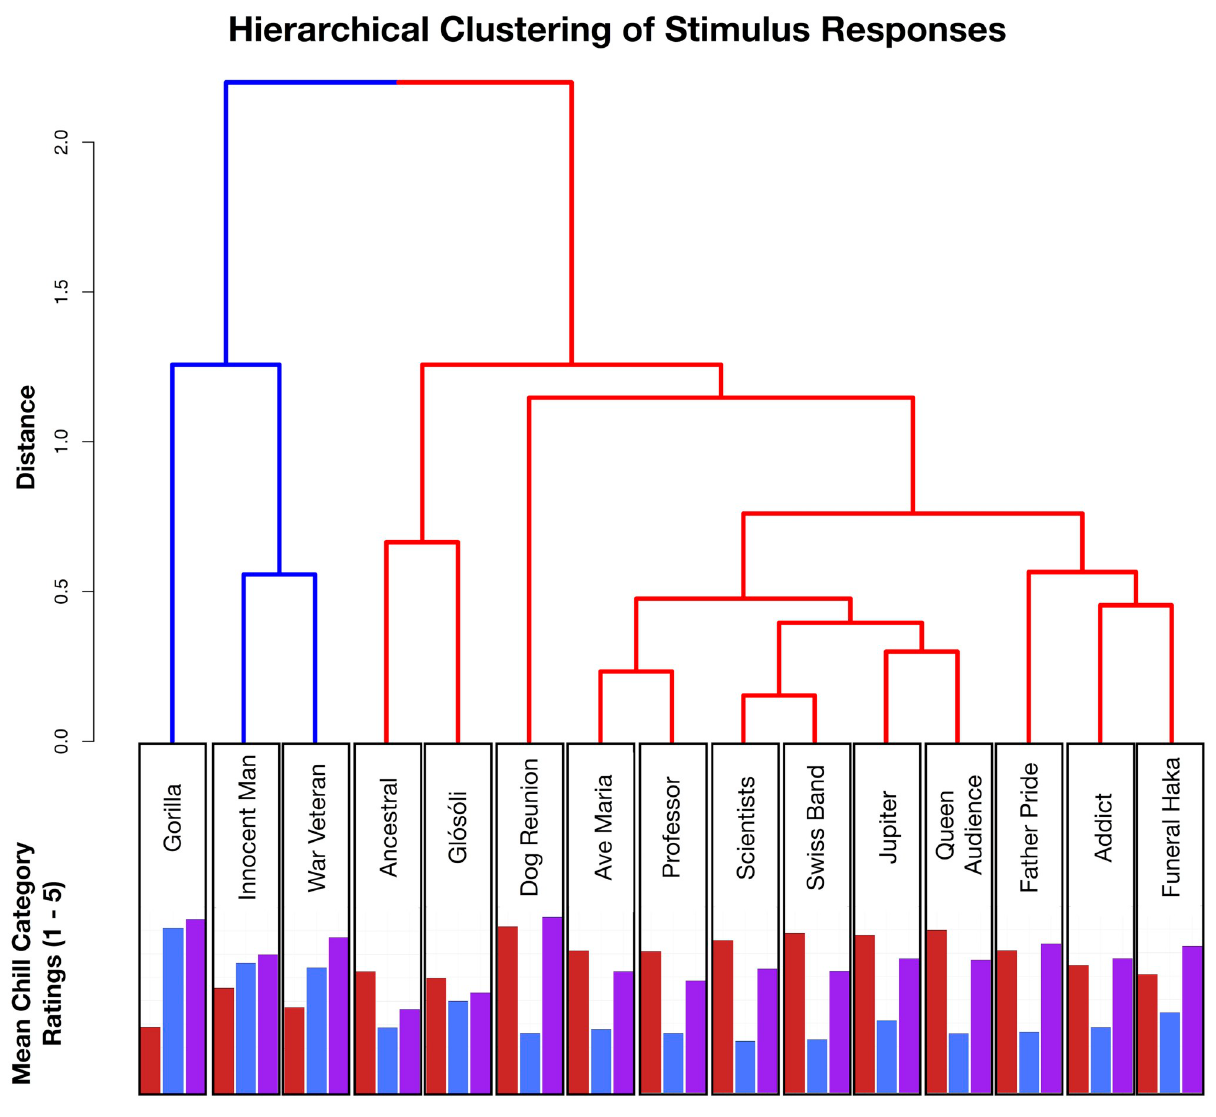
Fig 2. Full solution dendrogram from the agglomerative hierarchical cluster analysis. Red and blue branch colours indicate the two cluster solution representing positive and negative valence; smaller bar graphs indicate raw mean ratings for warm (red), cold (blue) and moving (purple) chills for each individual